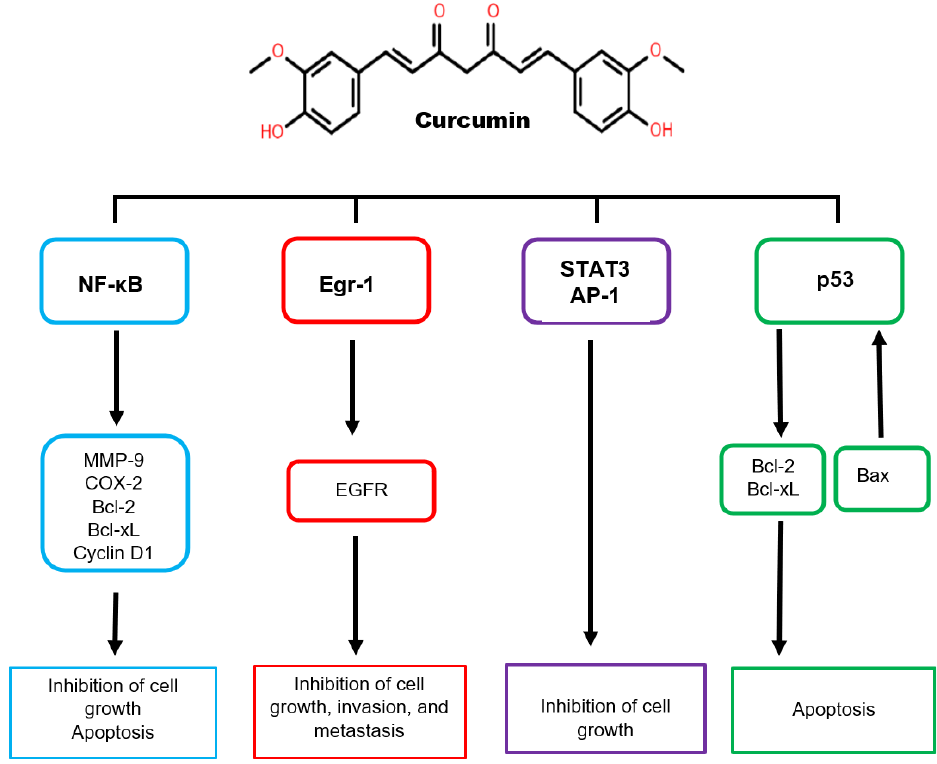
Figure 8. Antitumor effect of curcumin on the signaling pathways in cancer.